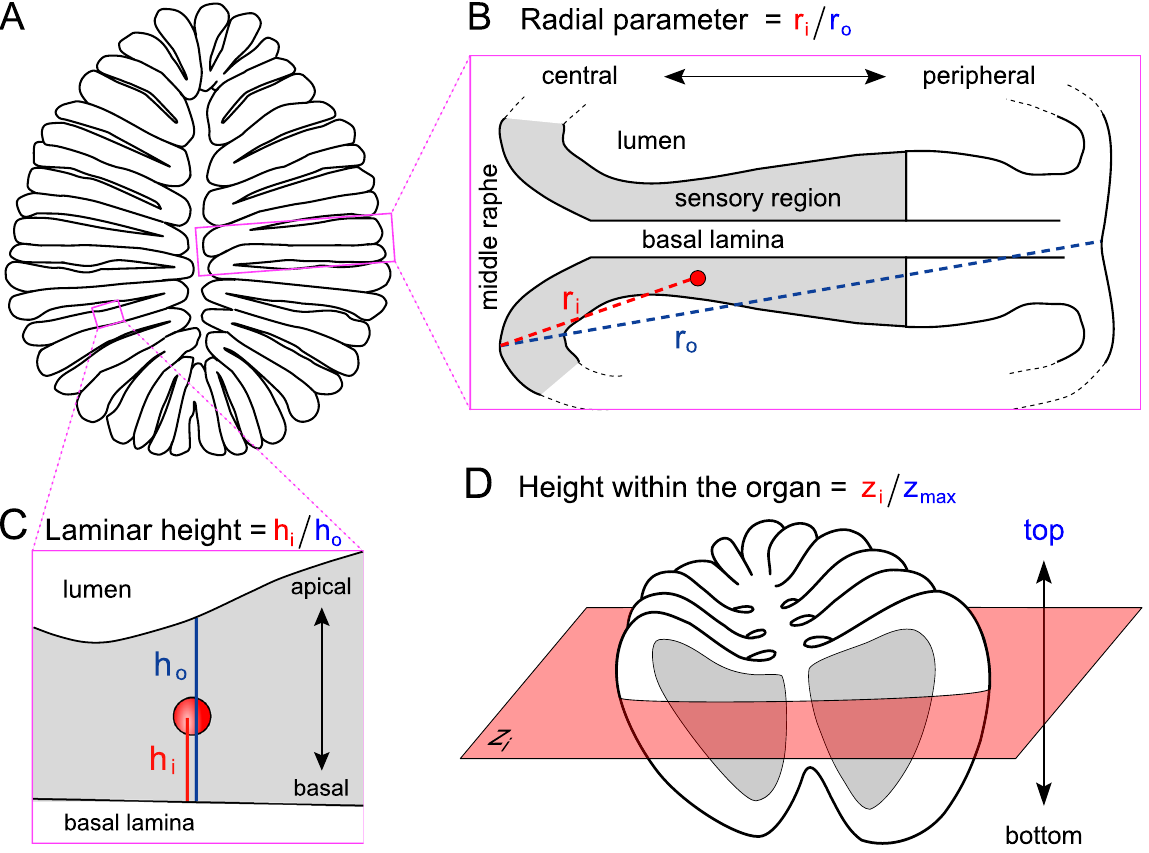
Figure 2. Schematic representation of spatial coordinates measured. ( A ) Horizontal cross section of an olfactory epithelium. ( B ) Enlargement shows the radial parameter (r i ), measured from middle raphe between lamellae to center of labeled cell and normalized to maximal radius (r o , including non-sensory area). One lamella is shown. ( C ) Enlargement shows the laminar height parameter (h i ), measured from the border between basal lamina and the sensory layer to center of labeled cell and normalized to maximal height (h o , measured at position of labeled cell, as laminar height varies throughout the lamella). ( D ) The complete olfactory organ, all three spatial coordinates are shown. height-within-the-organ is measured as section number z, beginning with the most basal section still containing sensory surface (bottom to